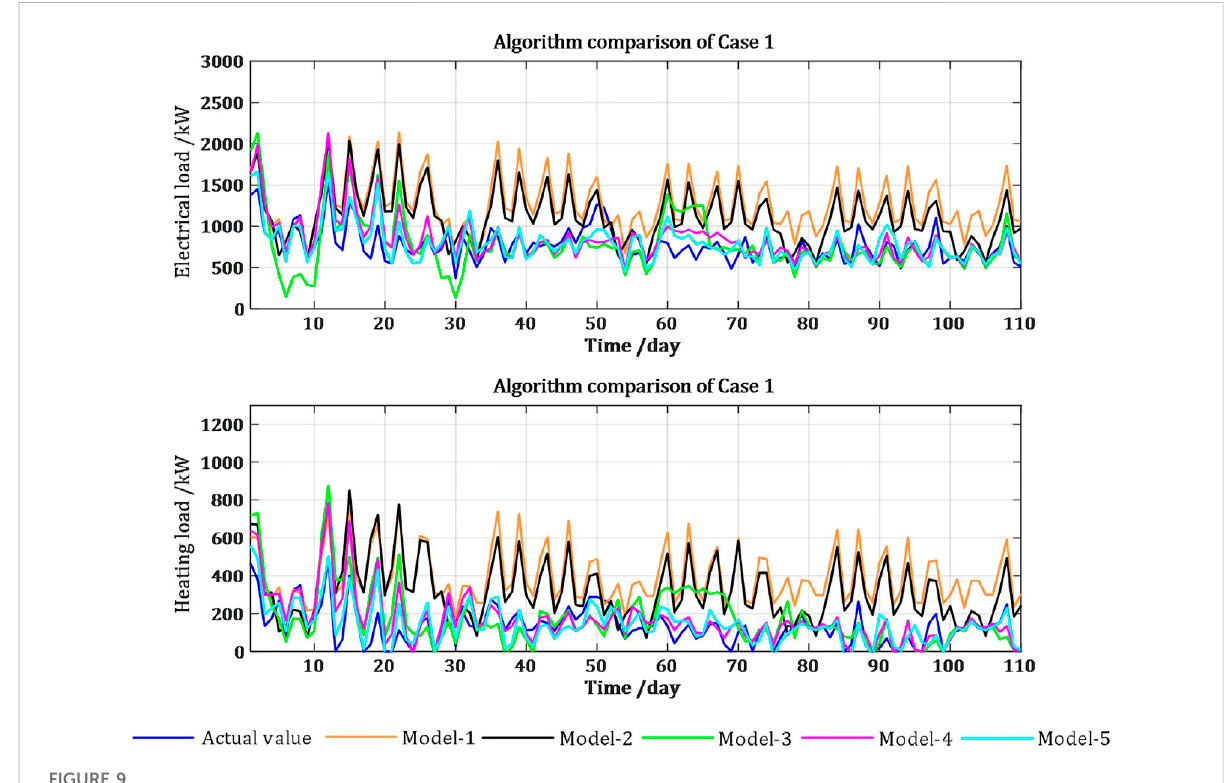
FIGURE 9 Comparison of the load forecasting results in Case